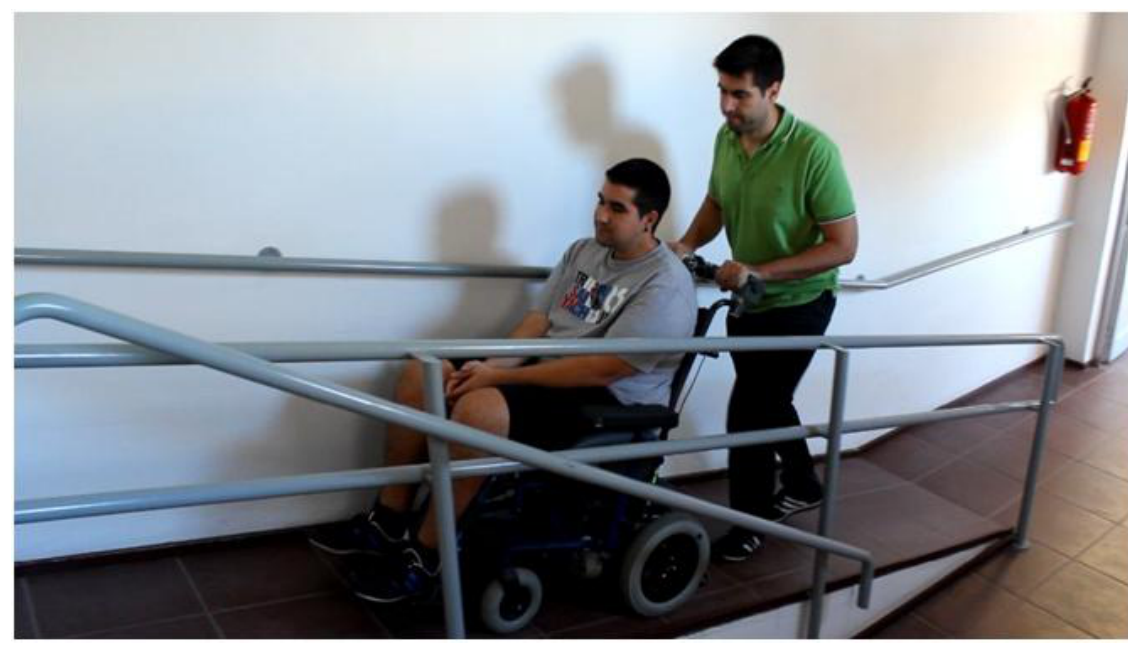
Figure 26. Driving on a